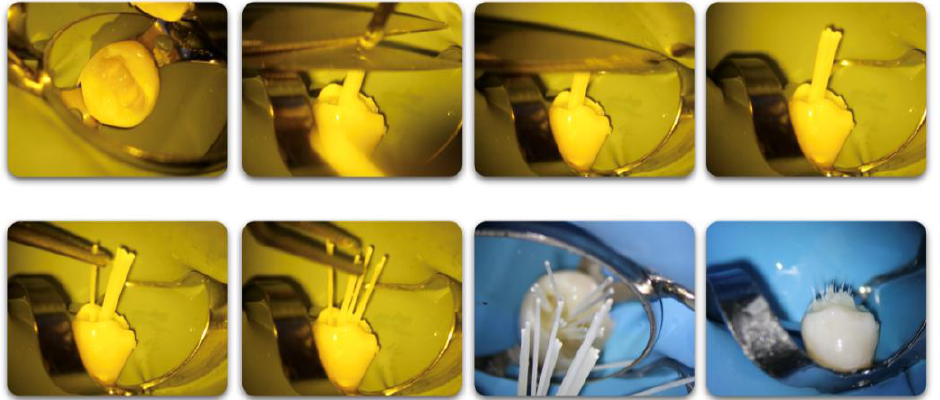
Figure 2. Multifilament fiberglass posts placement steps.